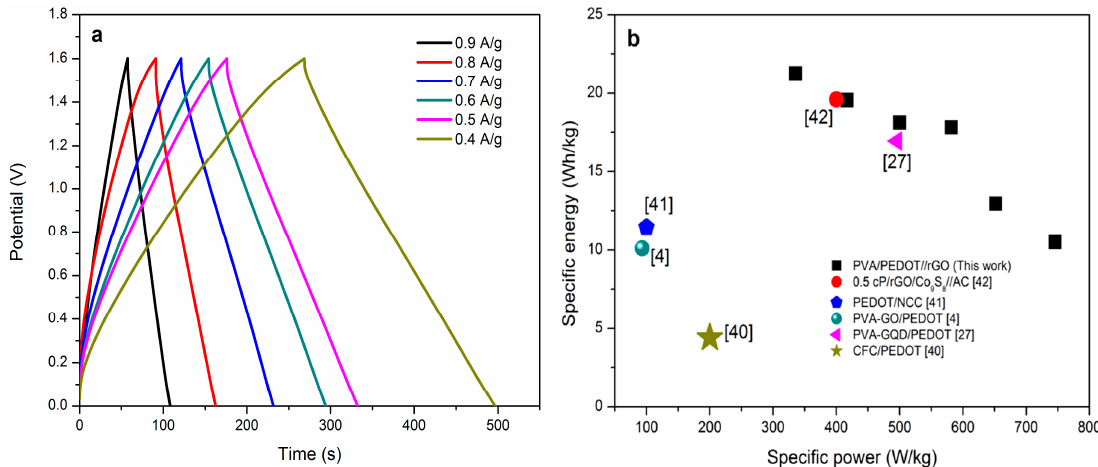
Figure 6. ( a ) Galvanostatic charge-discharge (GCD) curves at different current densities of PVA/PEDOT nanofibers//rGO. ( b ) Ragone plot of the asymmetric supercapacitor.